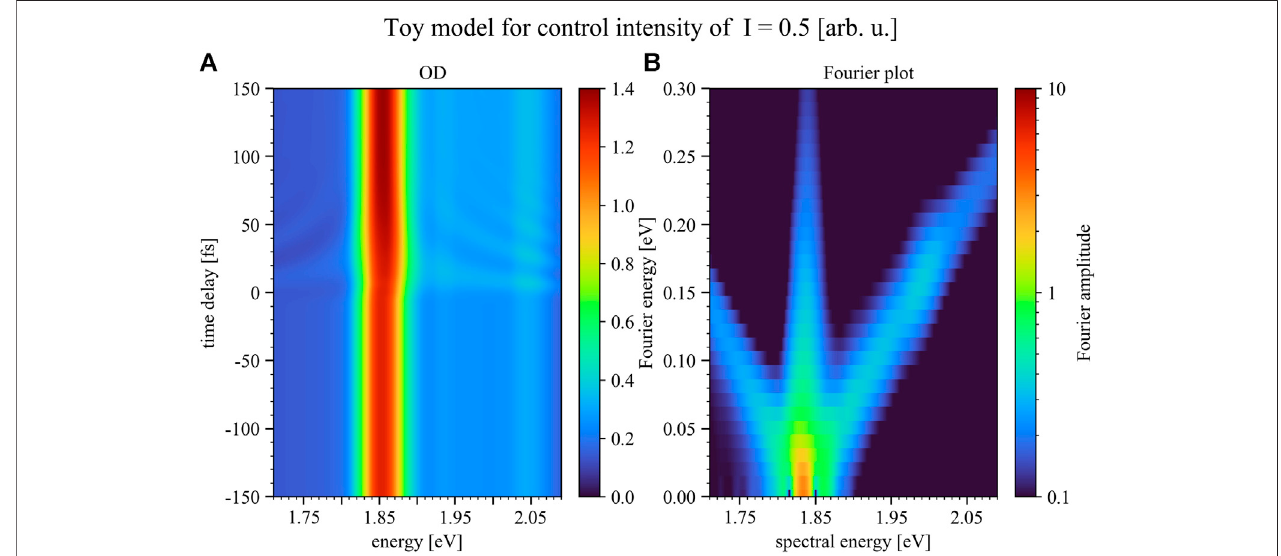
FIGURE8| Simulatedtimedelaytrace (A) andFourierplot (B) forpositivetimedelaysonly,butforthecaseofhalfthecontrol-pulseintensitycomparedto Figure7 . Panel 8A depicts the modeled optical density over a time-delay range of 300 fs, where the color bar marks the magnitude of the OD. The Fourier plot (Panel 8B) reveals less pronounced diagonals with slope ± 1 compared to the experimental data. As can be seen by lowering the intensity of the control pulse the structures upon the absorption decrease. Negative time delays refer to control-pulse fi rst, positive to excitation-pulse fi rst.